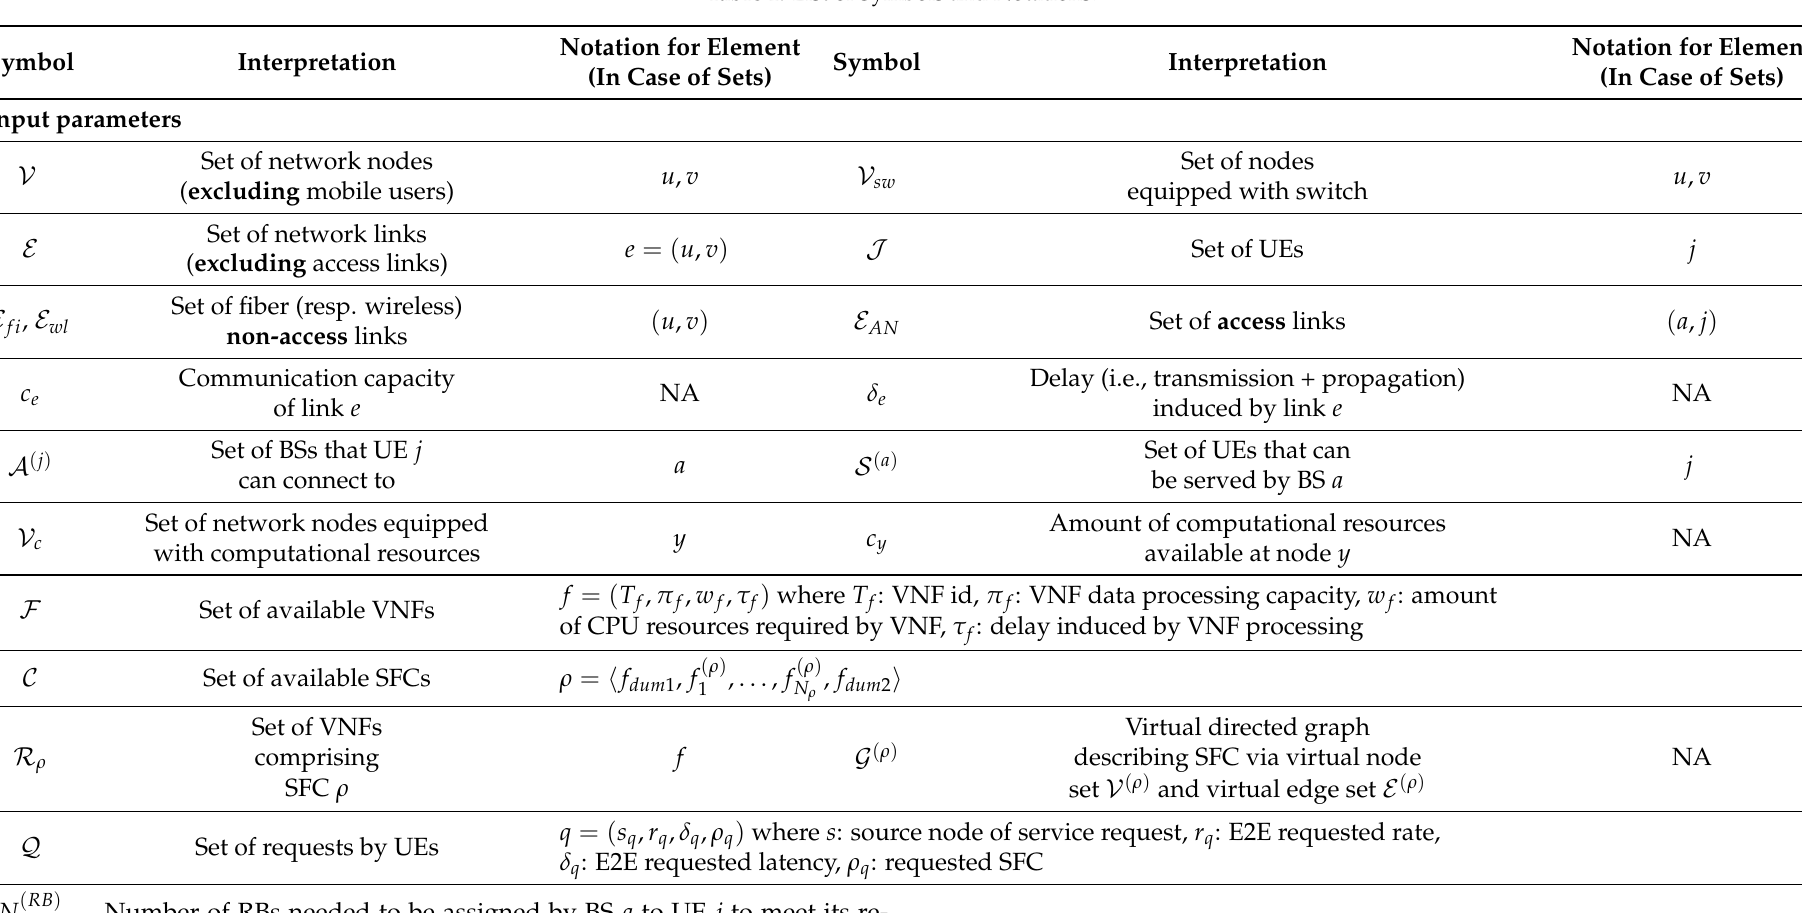
Table 1. List of Symbols and